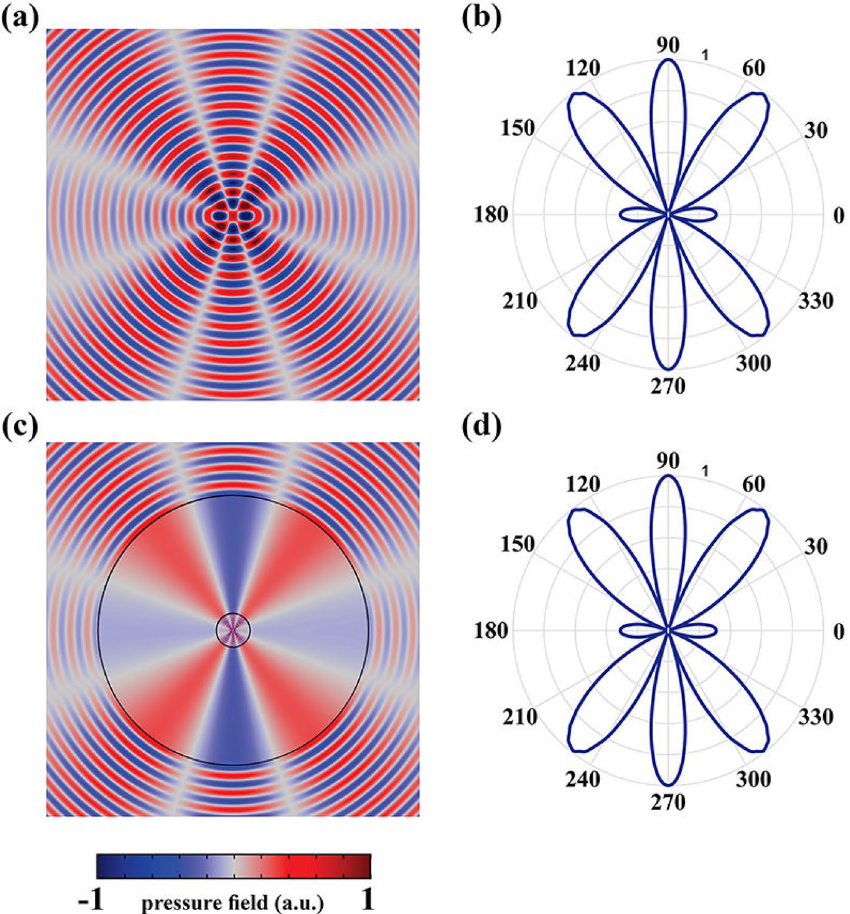
1.6 (cid:31) . ( c , d ) The =